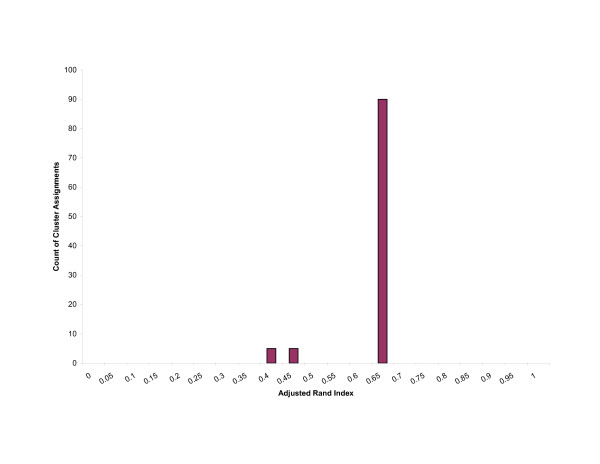
Validation of the cluster assignments for the acetaminophen data. modk-prototypes clustering of the acetaminophen data was performed 100 times at k = 3 using equal weighting of the microarray, clinical chemistry and histopathology domain data. The necrosis of the centrilobular region of the rat liver histopathology observation was removed from the data prior to clustering and used as an external indicator of cluster assignment validation. The adjusted Rand index (x axis) was computed for each clustering of the data and graphed by count (y axis) of cluster assignments scored with the range of the index.